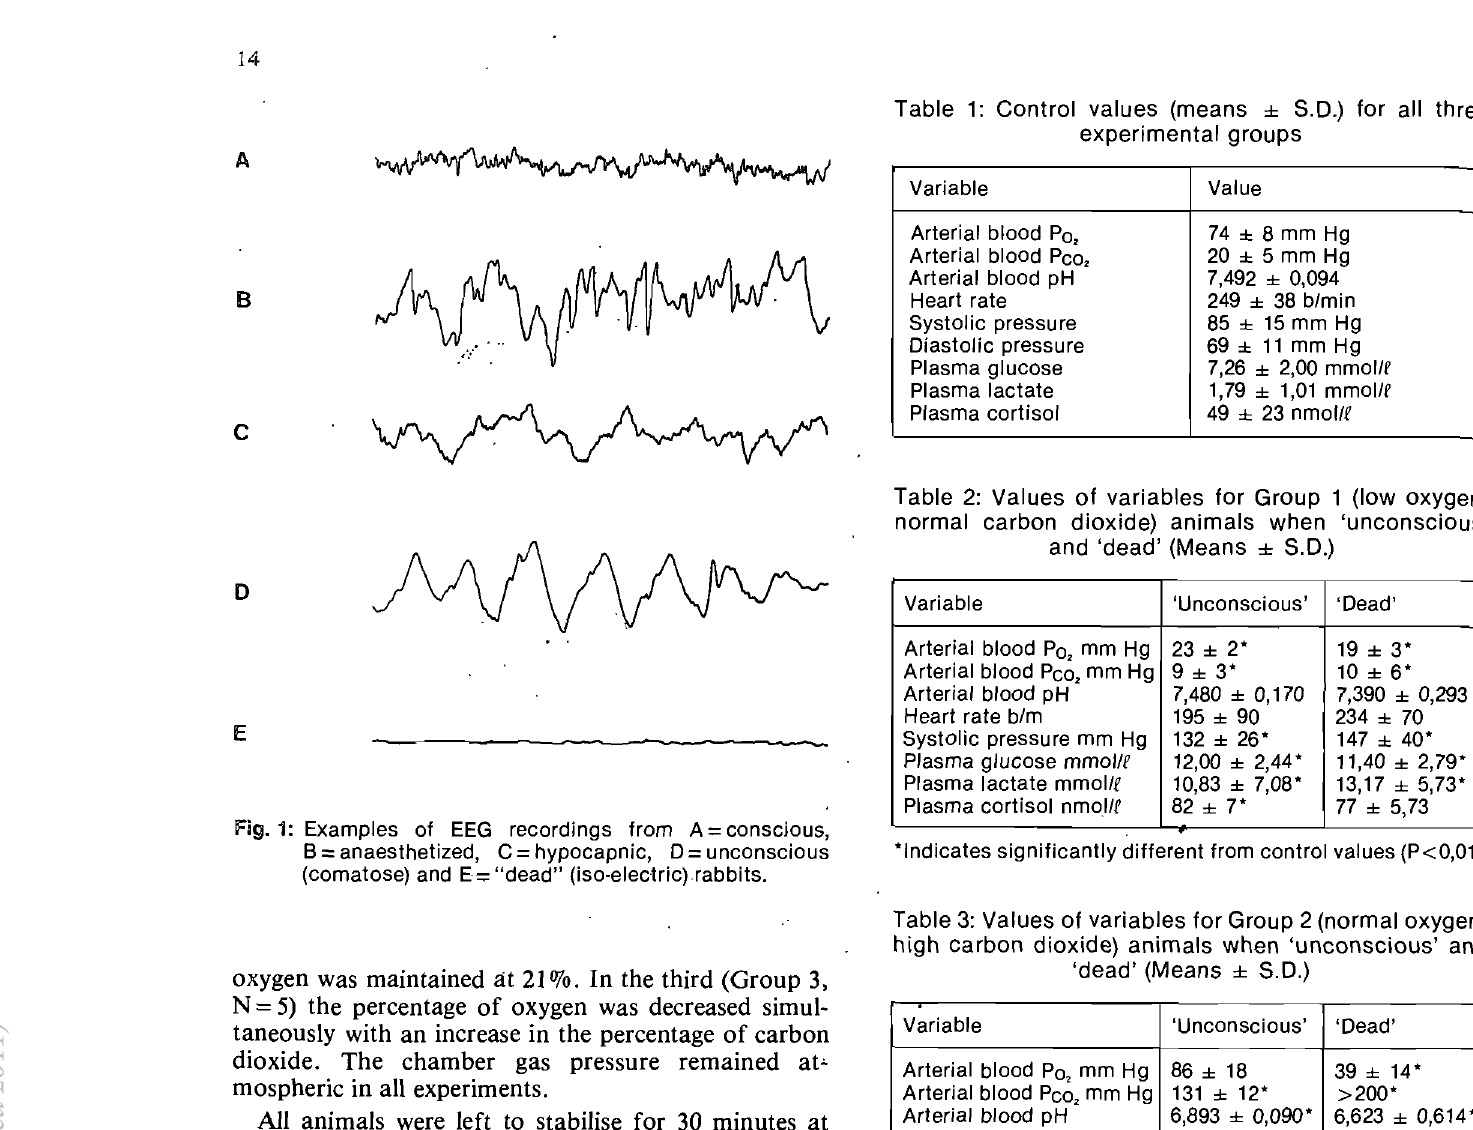
Fig. 1: Examples of EEG recordings from A::;: conscious, B::;: anaesthetized, C::;: hypocapnic, D::;: unconscious (comatose) and E::;: "dead" (iso·electric) rabbits.